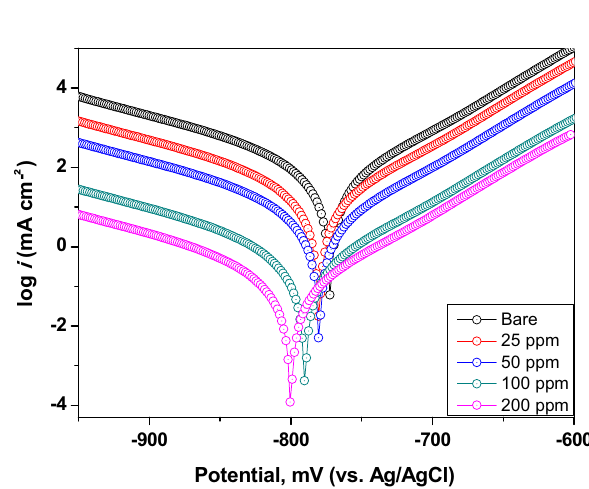
Table 1. Weight loss corrosion rate ( C.R .) and the protection efficiency ( ɳ w %) of the different coated mild steel samples as measured in 3.5 wt.% NaCl solution after 24 h immersion.